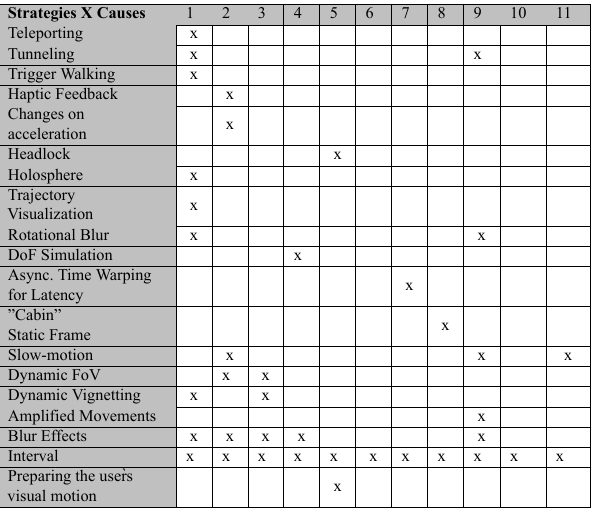
Table 2. Strategies associated with causes (1 ­ Locomotion , 2 ­ Ac­ celeration, 3 ­ Field of View, 4 ­ Depth Of Field, 5 ­ Degree of Control, 6 ­ Time Exposure, 7 ­ Latency, 8 ­ Static rest frame,